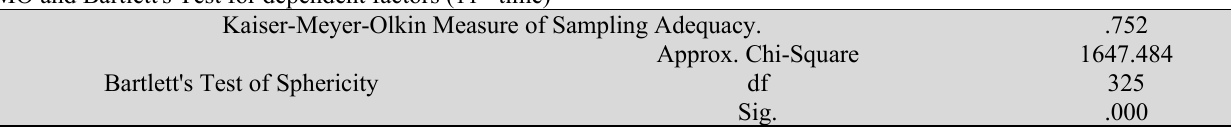
KMO and Bartlett's Test for dependent factors (11 th time)